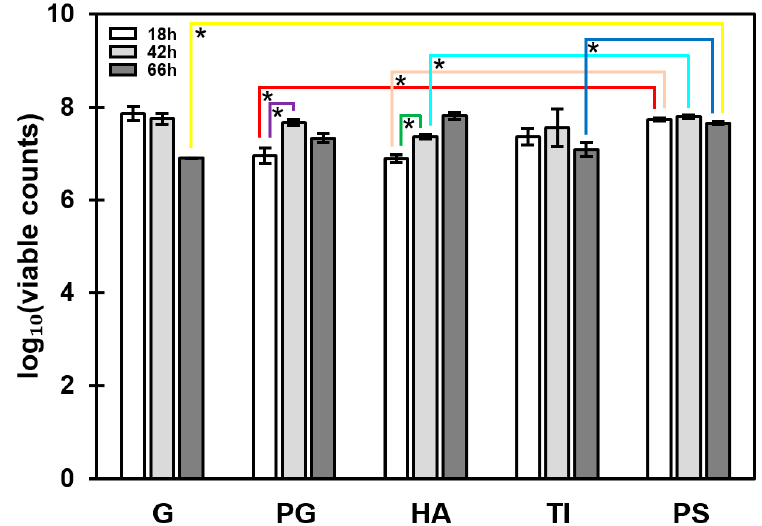
Figure 2. Formation of Staphylococcus aureus ATCC 25923 on five substrate materials. Bacterial attachment is expressed as log 10 values of CFU · (mL · cm 2 ) − 1 . Differences in attachment were assessed for a single material between different time points, and for a fixed time point between the different materials, using one-way ANOVA with Games–Howell post-test. *, significant difference ( p < 0.05). Error bars denote the standard error of the mean (SEM) ( n = 3). G, borosilicate glass; PG, plexiglass; HA, hydroxyapatite; TI, titanium; PS, polystyrene.